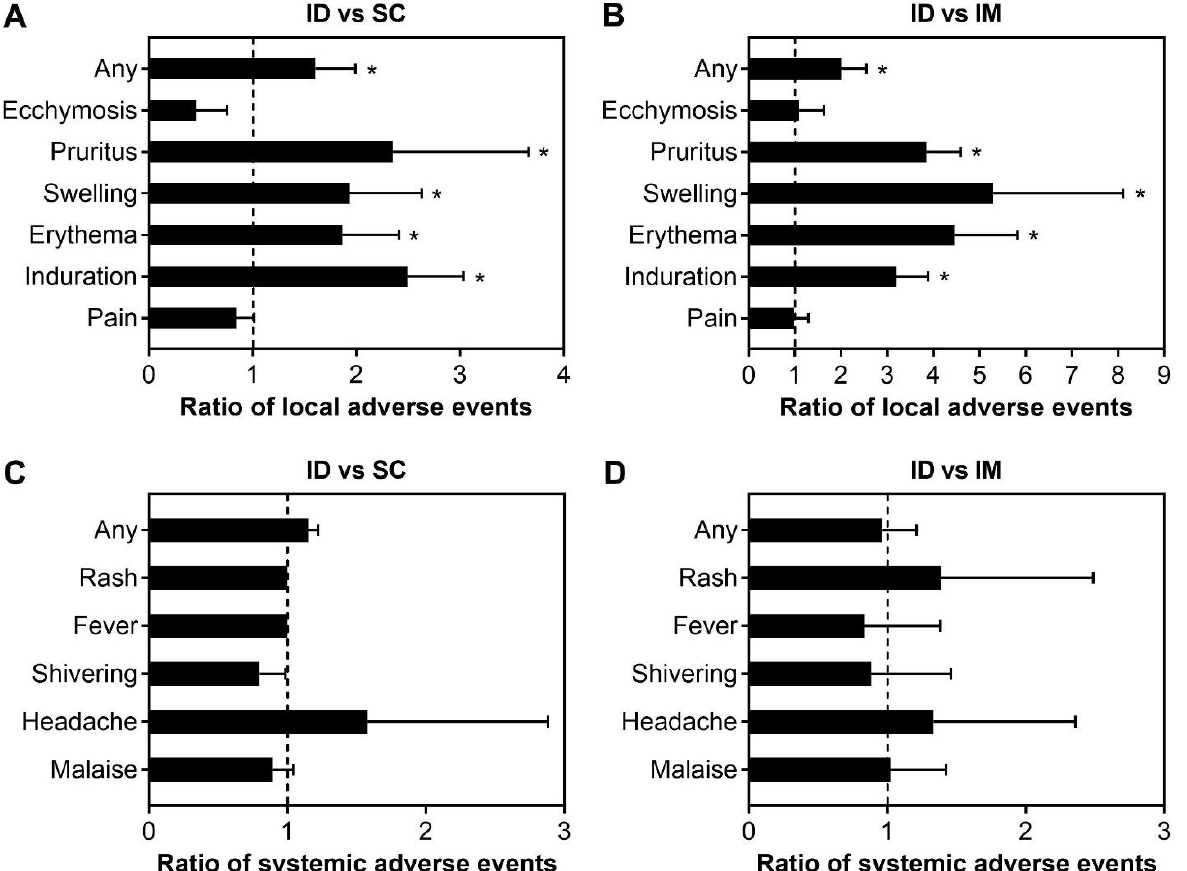
Figure 5. Comparison of the frequency of local and systemic adverse events elicited by ID versus SC vaccinations ( A , C ) and ID versus IM vaccinations ( B , D ) in the elderly. The ratios of the adverse events were calculated by dividing the frequency of these events elicited by ID route over SC or IM routes. A ratio of >1 (dash line) implies higher frequencies of local adverse events elicited by ID route. One sample t-test was used to examine the significant difference in the immunogenicity ratios against hypothesized ratio of 1 with “*” = p < 0.05. If not indicated, the difference in the ratio of adverse events was not statistically significant.